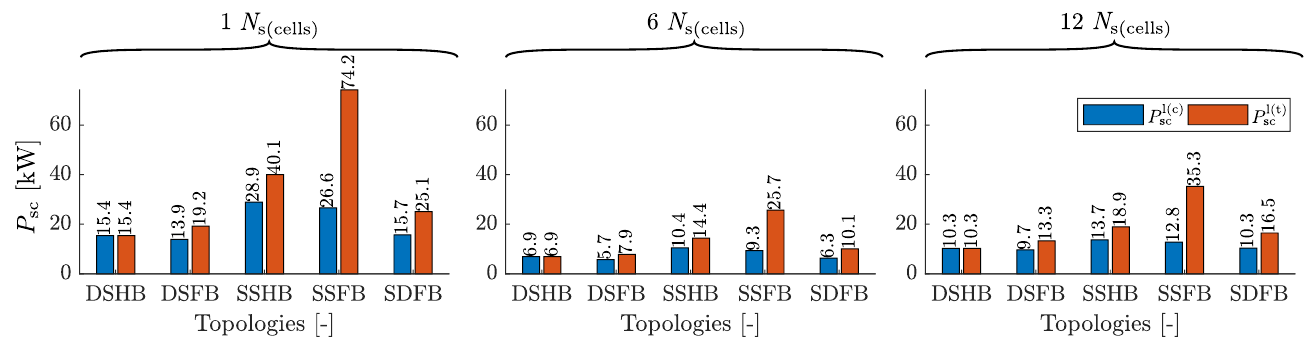
Figure 6. Total semiconductor losses considering both N t sm ( P l(t) sc ), CDC-T, and N c sm submodules ( P l(c) sc ), CDC-C, during traction at a maximum power of 400kW for all topologies with 1, 6, and 12 N s(cells)